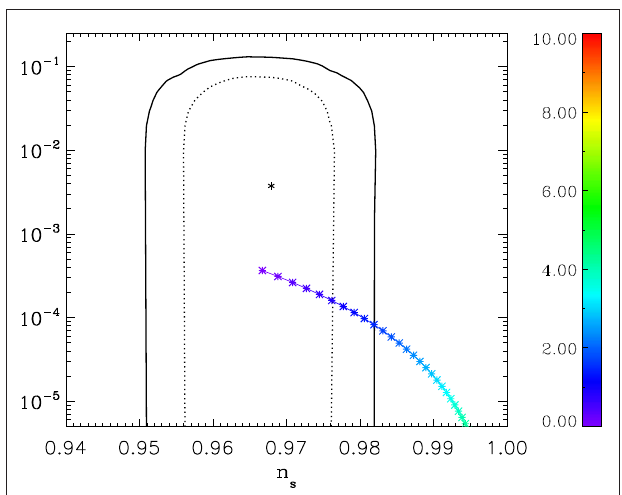
FIGURE 1 | Spectral index and tensor-to-scalar ratio induced by the family of theories in Equation (57) as a function of the power index p for N and b 1. Dashed and solid lines correspond to the 1 σ and 2 σ confidence = levels on the values of ( n s , r ) extracted from the Planck data [ 102]. The Starobinsky model, denoted with a star symbol, is also shown for comparison. Only theories with p 1 are reasonably within the 2 σ confidence-level ≤